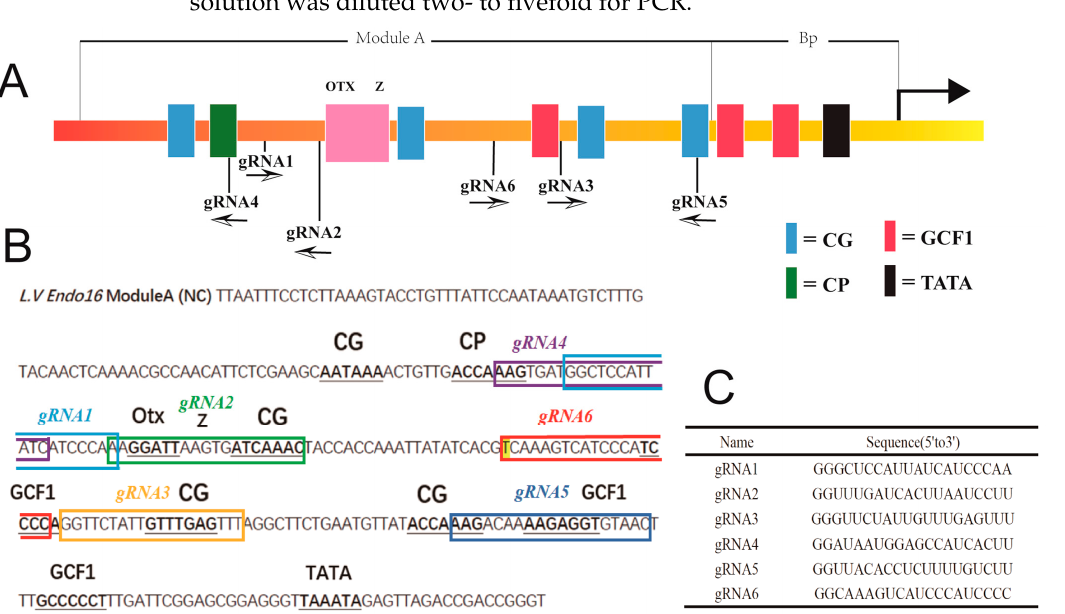
Figure 1. Positions and sequences of gRNAs targeting the Endo16 Module A. ( A ) A schematic representation of the Endo16 Module A locus and the positions of the six gRNAs. The arrows indicate the orientation of the gRNAs. The colored boxes indicate the binding sites with transcription factor. ( B ) The specific sequence of Endo16 Module A and binding sites. ( C ) The specific sequence of the six gRNAs.